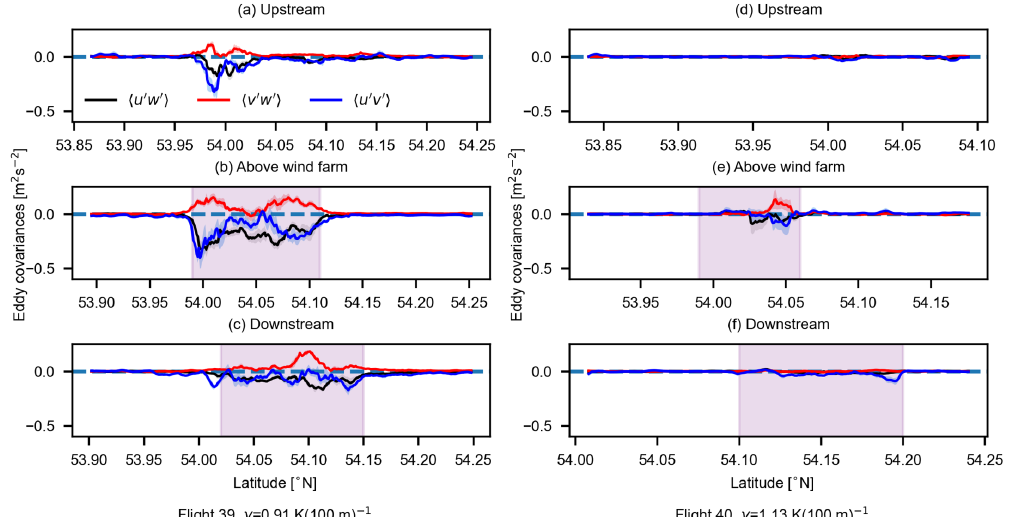
Figure 10. Same as Fig. 9, but for flight 39 and flight 40 (strong thermal